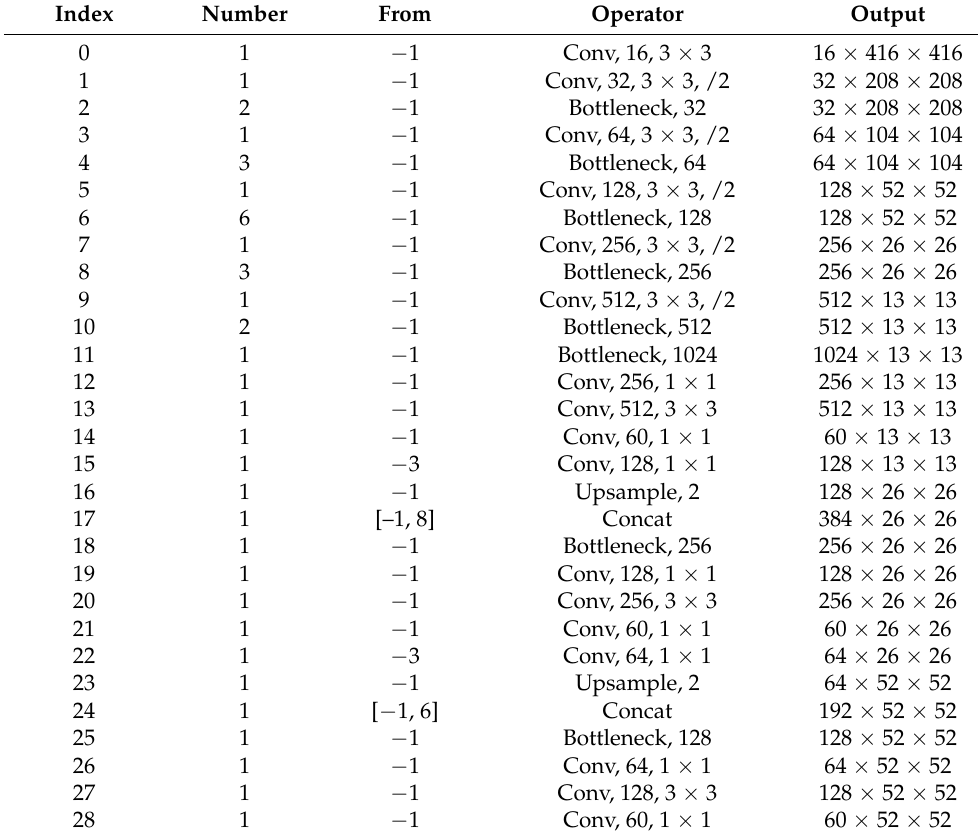
Table 2. The detailed structure of